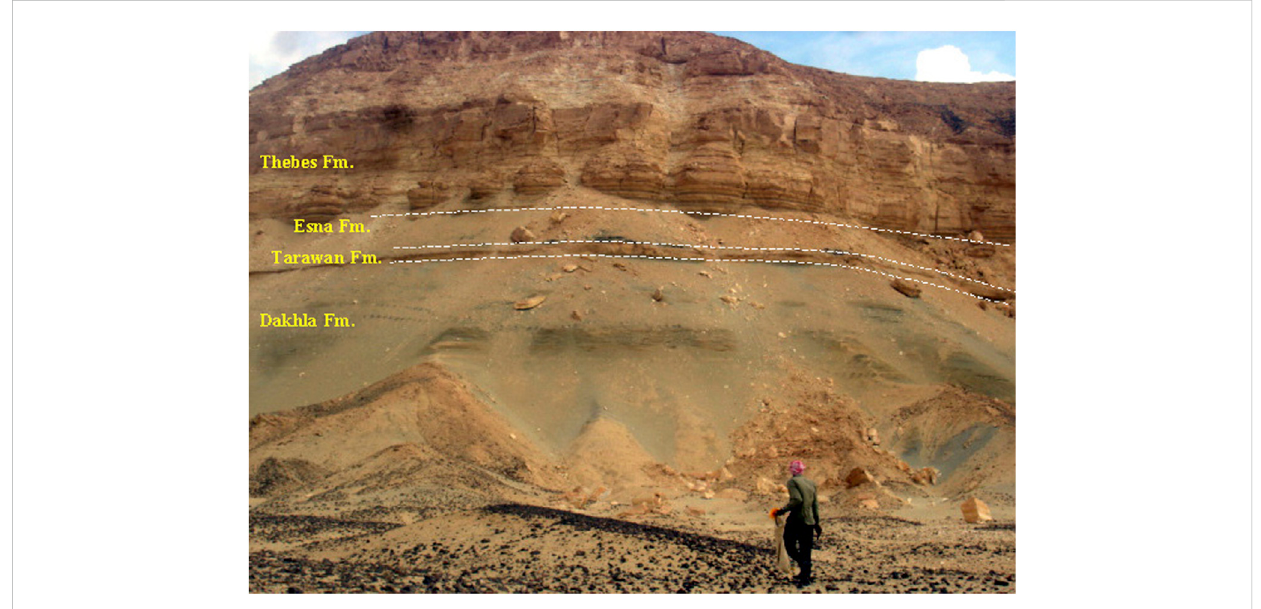
FIGURE 2 Outcrop of Themed section showing exposures of the Dakhla, Tarawan, Esna and Thebes